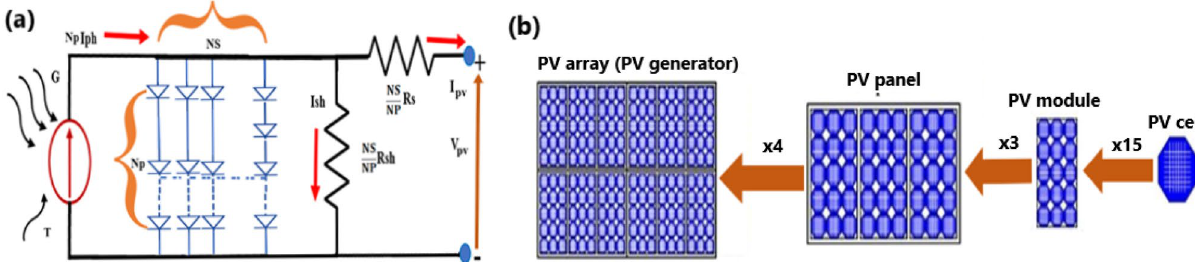
Figure 2. PV module equivalent circuit ( a ). photovoltaic array pyramid ( b